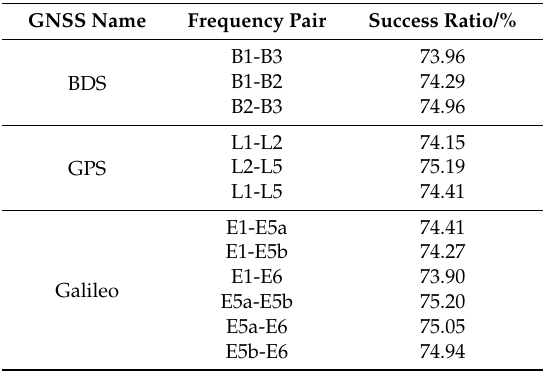
Table 3. The ratio for which the DDGF detection is able to work.